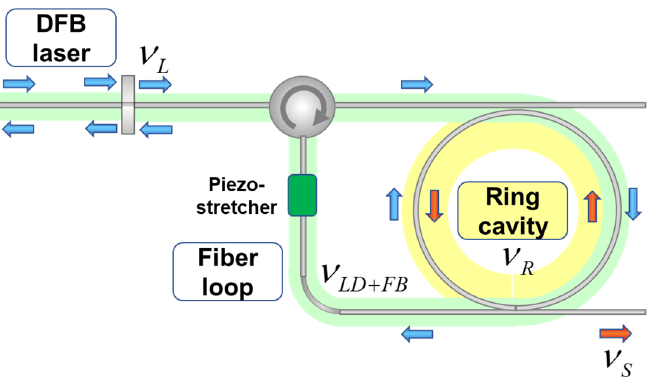
Figure A2. Illustration to dual-frequency laser operation. Green background shows the coupled cav- ity comprising the DFB laser and feedback loop; yellow background marks the ring